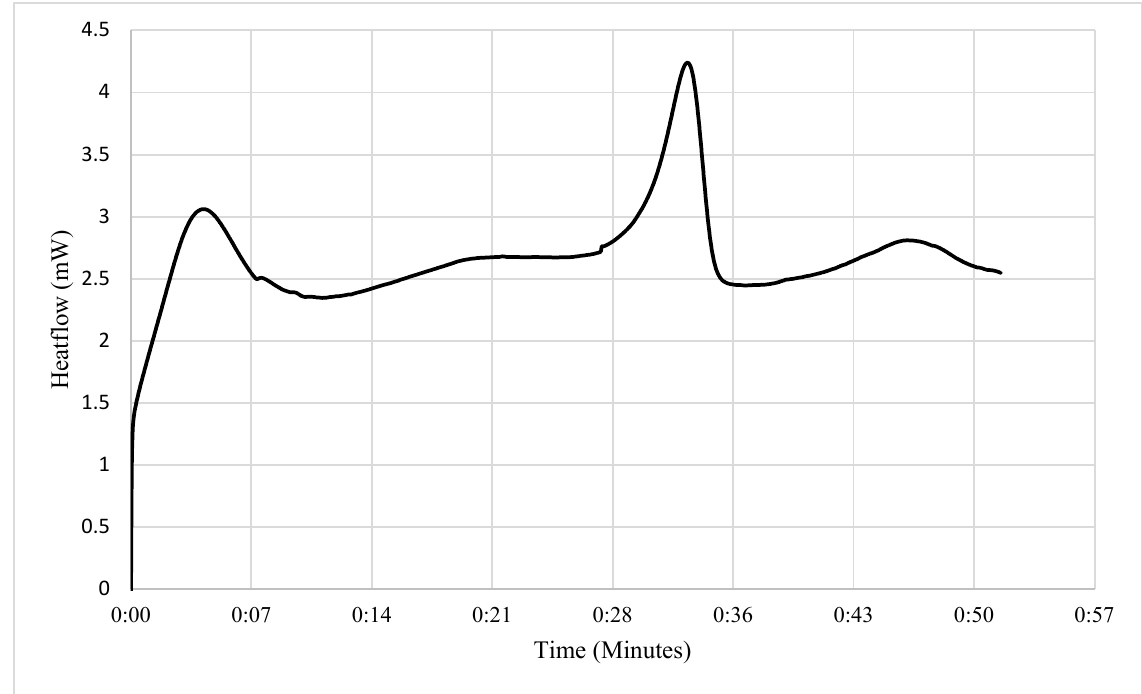
Figure 4. DSC curve of SFKFs showing three different endothermic processes .